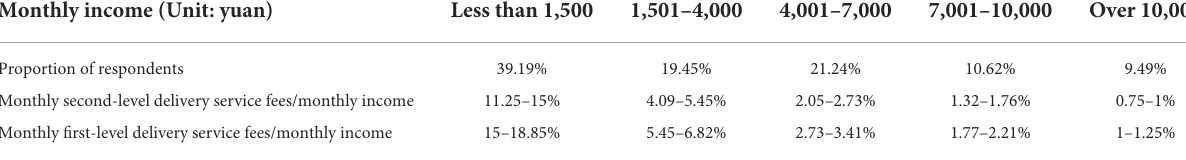
TABLE 6 The proportion of respondents’ monthly income and priority delivery service